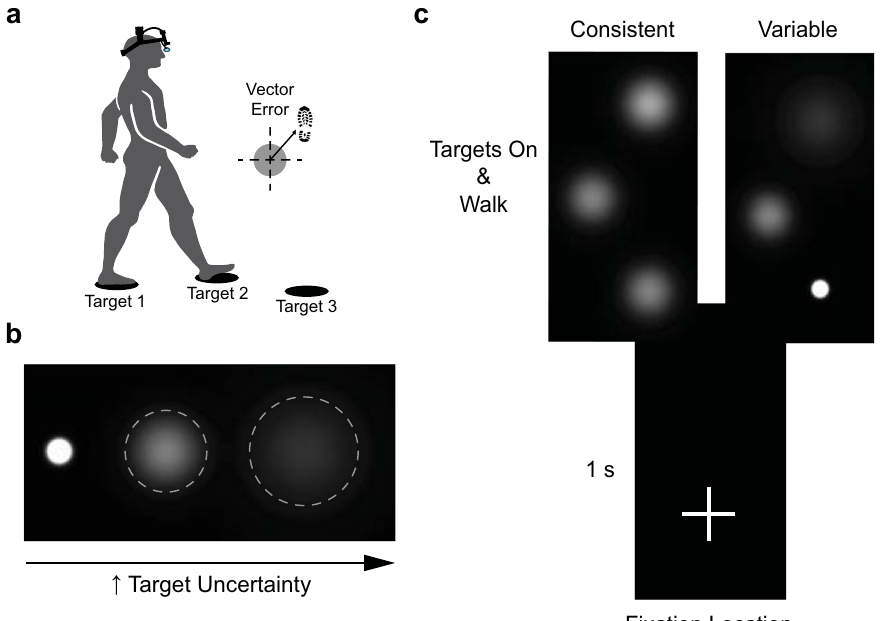
Figure 1. Experimental setup and procedure. ( a ) Visually guided walking paradigm and schematic of vector foot-placement error. ( b ) White two-dimensional Gaussian blob targets for each uncertainty condition. Grey dashed circles show the approximate size of the Medium and High uncertainty targets. These circles are for illustrative purposes only and did not appear during testing. ( c ) Each trial started with subjects fixating a plus sign on the walkway (at a distance of 50 cm with respect to the start position). After one second, we displayed all three targets at random positions and removed the fixation symbol. This signalled to the subjects to start walking. Examples of the Medium uncertainty condition for the consistent environment and one configuration of the variable environment are shown. Person illustration by Amanda Bakkum in ( a ) used with